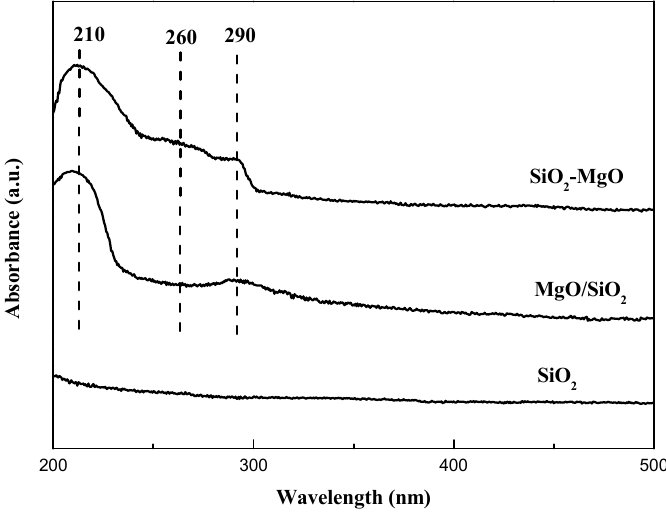
Figure 4. UV-Vis spectra of the supports.